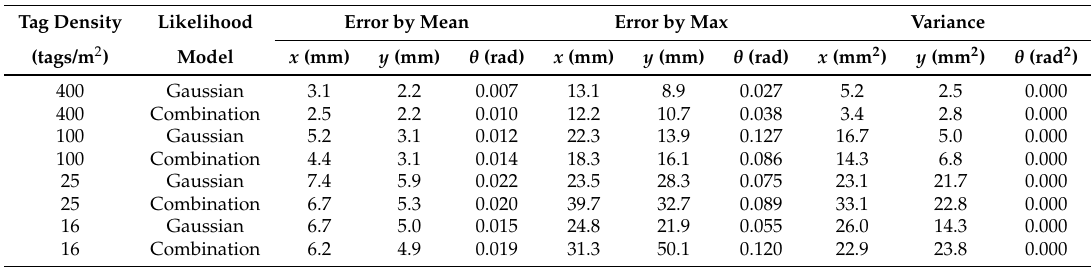
Table 4. Self-localization performances of the eight HF-band RFID reader system using two likelihood